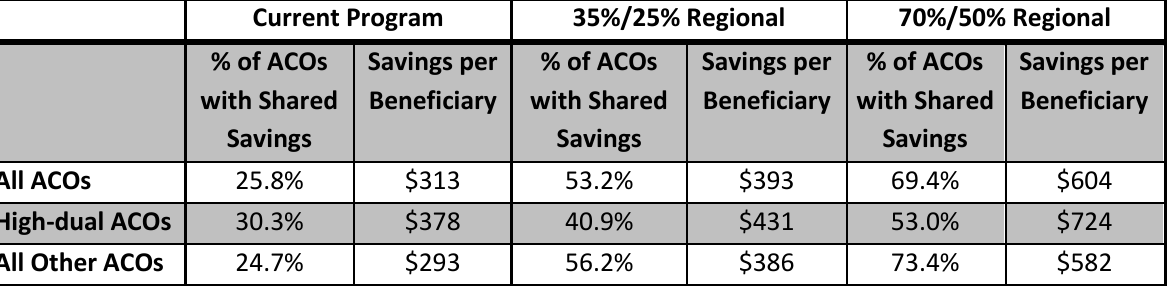
Table 9.16: Simulated Effects of Rebased ACO Benchmarks Incorporating Regional Spending and Trends